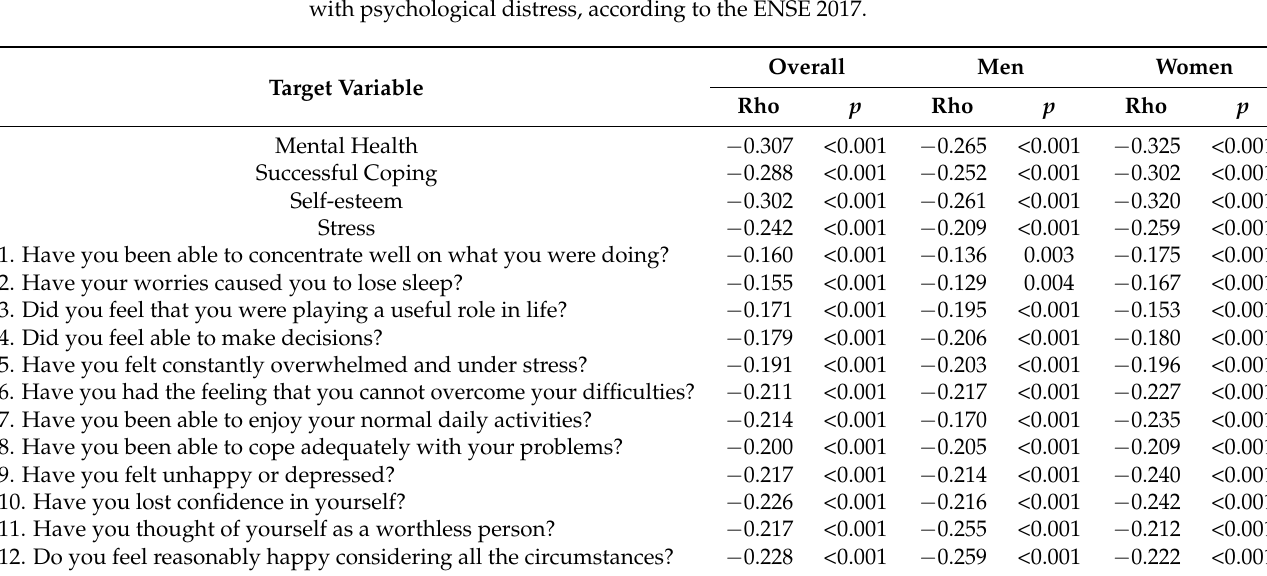
Table 4. Correlations between perceived social support in the Duke-UNC-11 Functional Social Support Questionnaire and the Goldberg General Health Questionnaire (GHQ-12) in Spanish adults with psychological distress, according to the ENSE